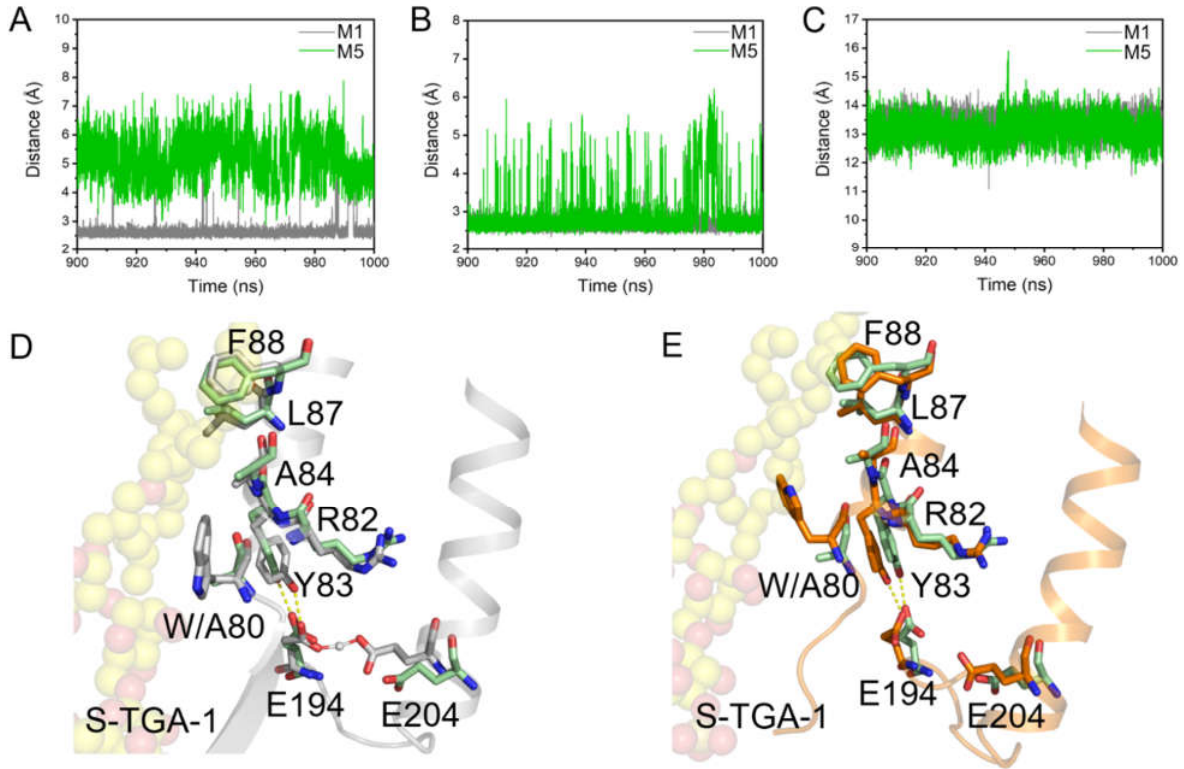
Figure 7. Dynamic conformation changes of the key residues on the extracellular side of bR induced by the W80A mutation. ( A – C ) The evolution of the distance between the key residues from the last 100 ns simulations of M1 (grey line) and M5 (green line): ( A ) E194-E204; ( B ) Y83-E194; ( C ) R82-A51. This behavior could be reproduced in the second time-repeat simulation (Figure S8 and Table S4); ( D , E ) superimposed drawing of several key residues on the extracellular side: ( D ) M1 (grey cartoon and sticks) vs. M5 (pale green sticks); ( E ) M2 (orange cartoon and sticks) vs. M5. Yellow spheres highlight